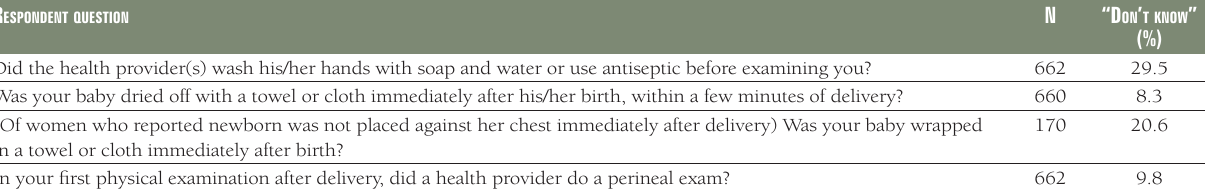
Table 3. Indicators with greater than 5% “Don’t know” responses